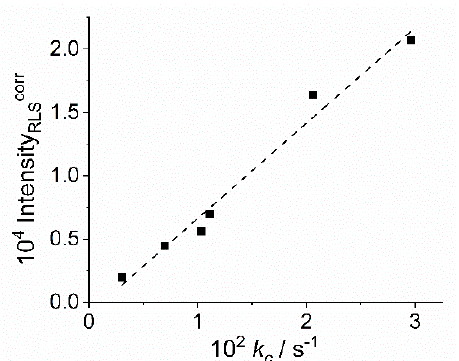
Figure 6. Plot of the RLS intensity at maxima corrected for the extinction of the samples as a function of the corresponding rate constants k c for the J-aggregation catalyzed by CoT 4 . (Experimental conditions: [TPPS 4 ] = 3 μ M; [CoT 4 ] = 1.5 μ M; [HCl] = 0.00158 M, T = 298 K). The line represents the linear best fit to the experimental data (I RLScorr = 10 5 × ( − 0.009 ± 0.009) + 10 5 (7.531 ± 0.556) × k c ).